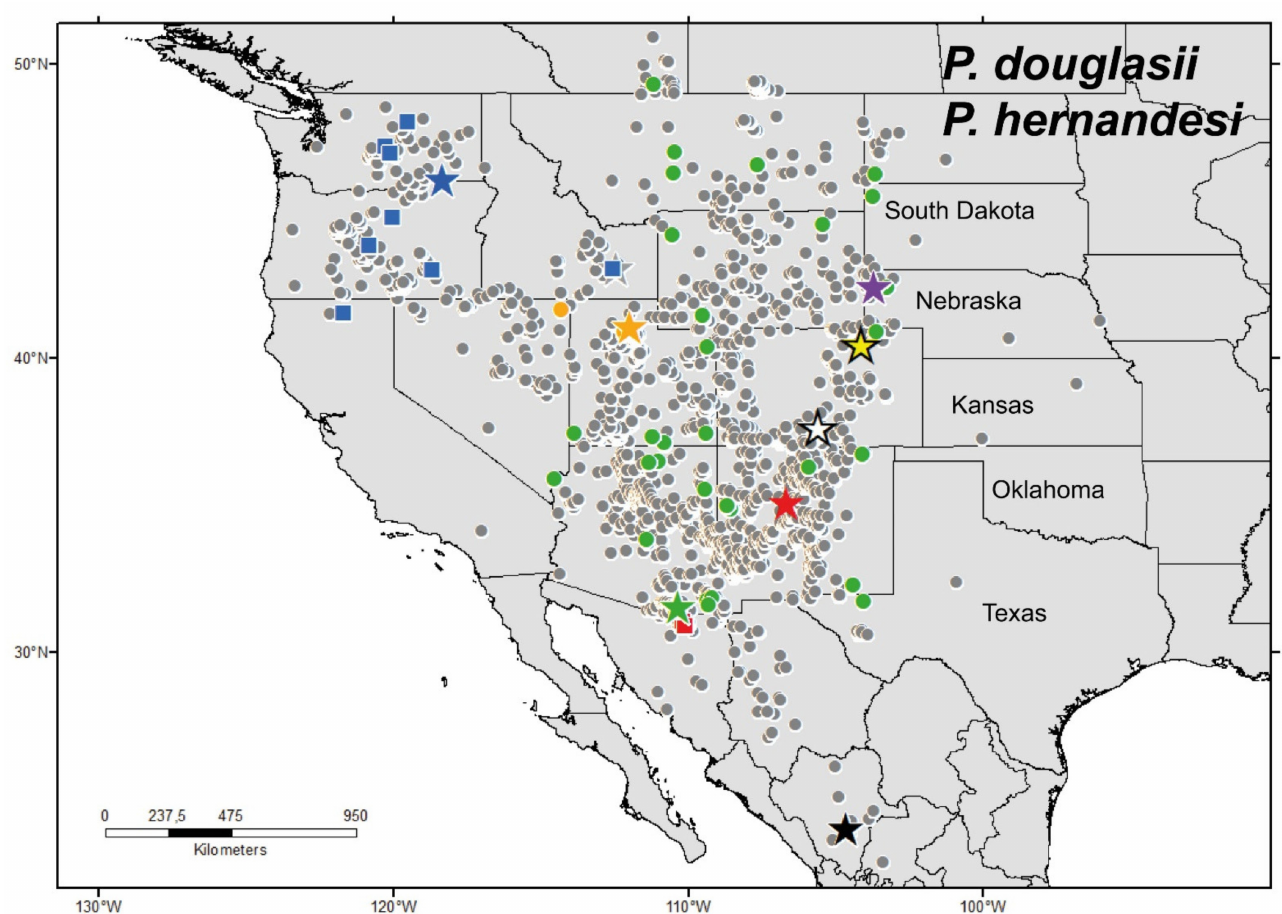
Figure 10. Map showing distributional records of Phrynosoma douglasii and P. hernandesi . Blue squares = genetically confirmed records of P. douglasii ; green circles = genetically confirmed records of P. hernandesi; orange circles = genetically confirmed records of P. h. ornatum; red squares = genetically confirmed records of P. h. ditmarsi; gray circles = records that have not been genetically confirmed; blue star = type locality of P. pygmaea ; gray star = restricted type locality of P. exilis ; orange star = type locality of P. ornatum ; green star = restricted type locality of P. hernandesi ; purple star = restricted type locality of P. brevirostris ; black star = restricted type locality of Phrynosoma douglassii brachycercum ; red star = restricted type locality of P. ornatissima ; yellow star = type locality of P. bauri ; white star = type locality of P. diminutum . The type localities of P. douglasii and P. ditmarsi are too imprecise to